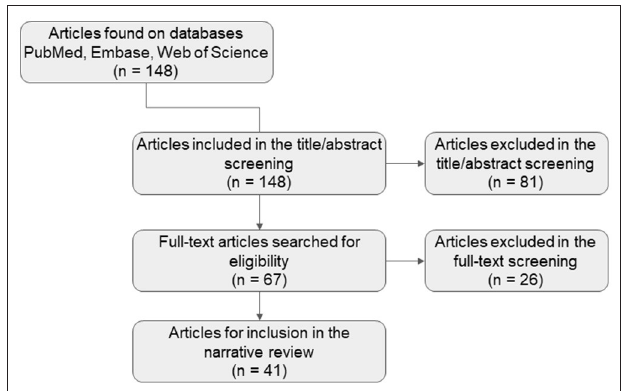
FIGURE 1 | Literature search process